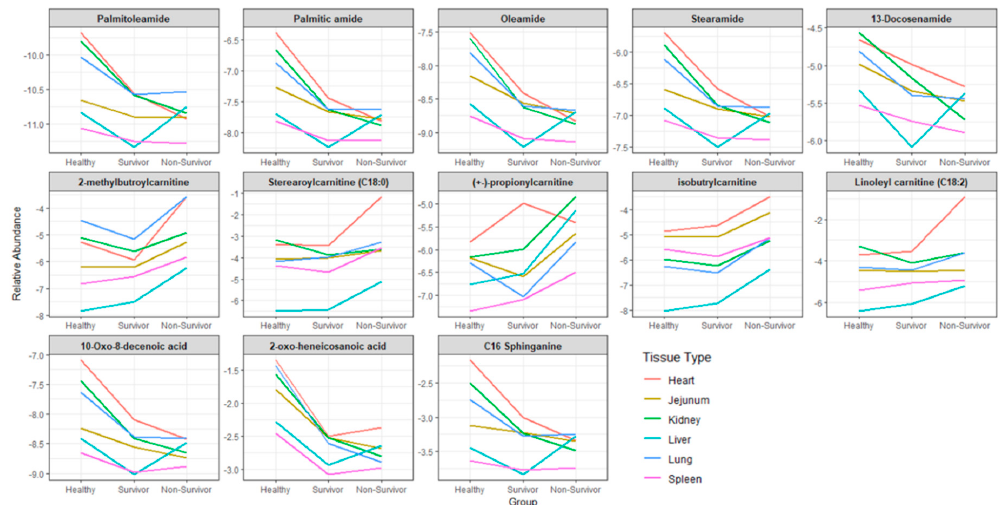
Figure 6. Overlapping patterns of metabolite abundance in the three NHP study groups across different tissue types. The Y-axis shows mean values for the log-transformed and Pareto scaled relative abundances.